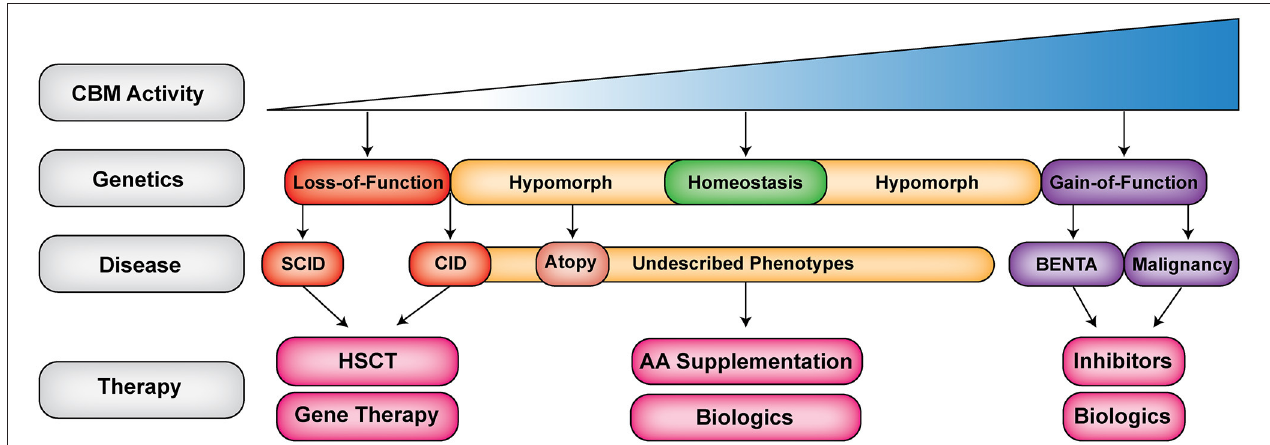
FIGURE 3 | The expanding clinical spectrum of CBM-opathies. Shown is a gradient of CBM activity caused by germline mutations. Activity ranges from absent to hyperactive CBM activity. Red indicates loss-of-function (LOF) mutations (CARD11, BCL10, and MALT1 deficiencies), yellow indicates hypomorphic mutations that do not completely abrogate signaling leading to combined immunodeficiency and atopy as well as novel emerging phenotypes (DN LOF CARD11 ), purple indicates gain-of-function (GOF) mutations that can lead to BENTA (GOF CARD11 ) or malignancy (somatic GOF in CBM). Biologics refer to antibodies, which target cells, cytokines or cell surface receptors. SCID, severe combined immunodeficiency; CID, combined immunodeficiency; AA, amino acid; HSCT, hematopoietic stem cell transplantation.